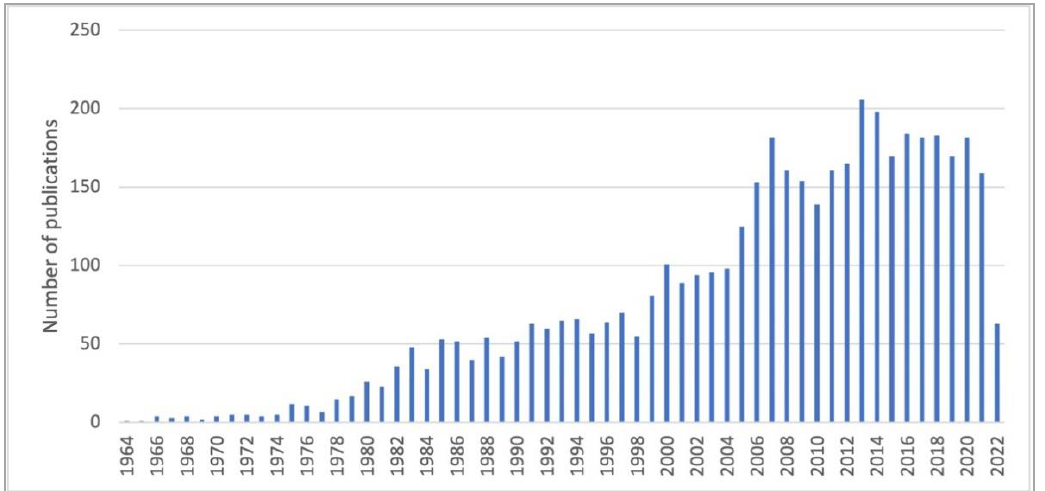
Figure 3. Evolution of the number of publications available on PubMed for halogenation enzymes (keywords used for the research on PubMed: haloperoxidase, chloroperoxidase, bromoperoxidase, iodoperoxidase, and halogenase).